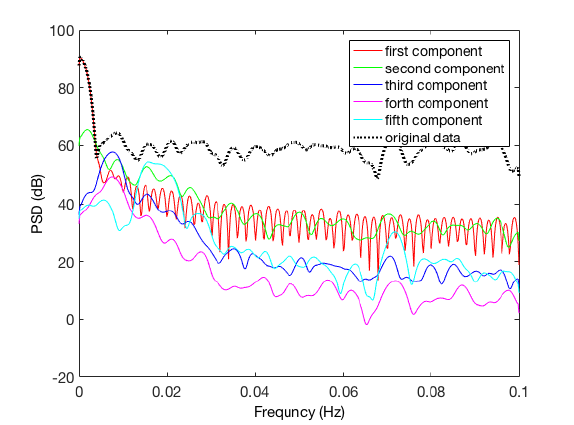
Figure 5. Frequency domain analysis